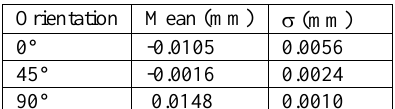
Figure 14: Mean and standard deviation for deviation in hole radii at varying orientations at 1.6 times magnification